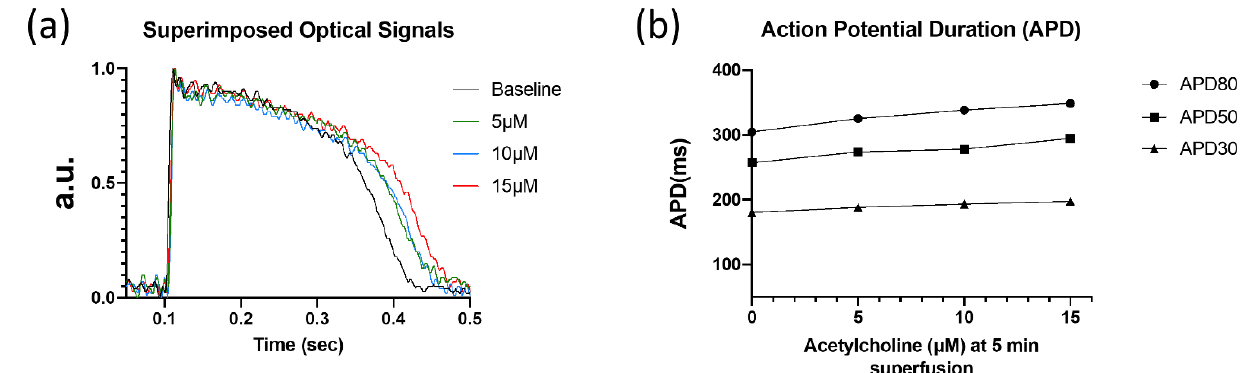
Figure 2. Optical recordings of human left ventricular myocardial slice. ( a ) Superimposed optical mapping recording of human left ventricular APs during control (‘base’) and after superfusion with ACh (5, 10, and 15 µM) at a BCL of 1000 ms. ( b ) AP duration at 30, 50, and 80% repolarization (APD 30 , APD 50 , and APD 80 , respectively) under control conditions and after superfusion with ACh at a BCL of 1000 ms.